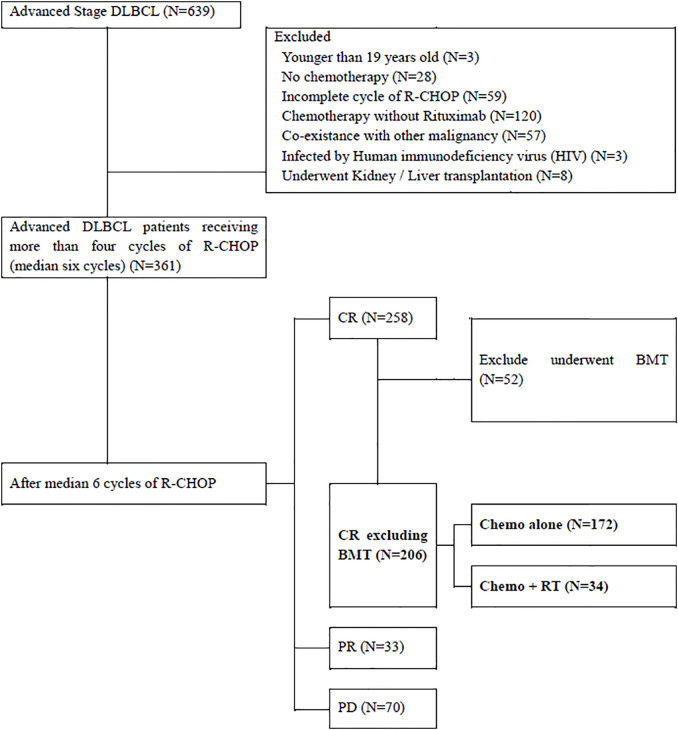
Inclusion Criteria. DLBCL, Diffuse Large B-cell lymphoma; CNS, Cranial Nervous System; R-CHOP, rituximab combined with cyclophosphamide, doxorubicin, vincristine, and prednisone; CR, complete remission; BMT, bone marrow transplantation; PR, partial remission; PD, progressive disease; RT, radiotherapy.